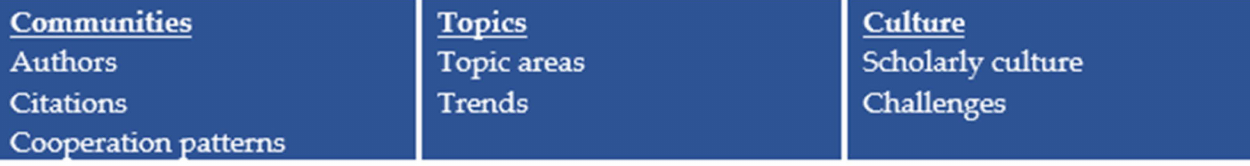
Figure 7. Chapter